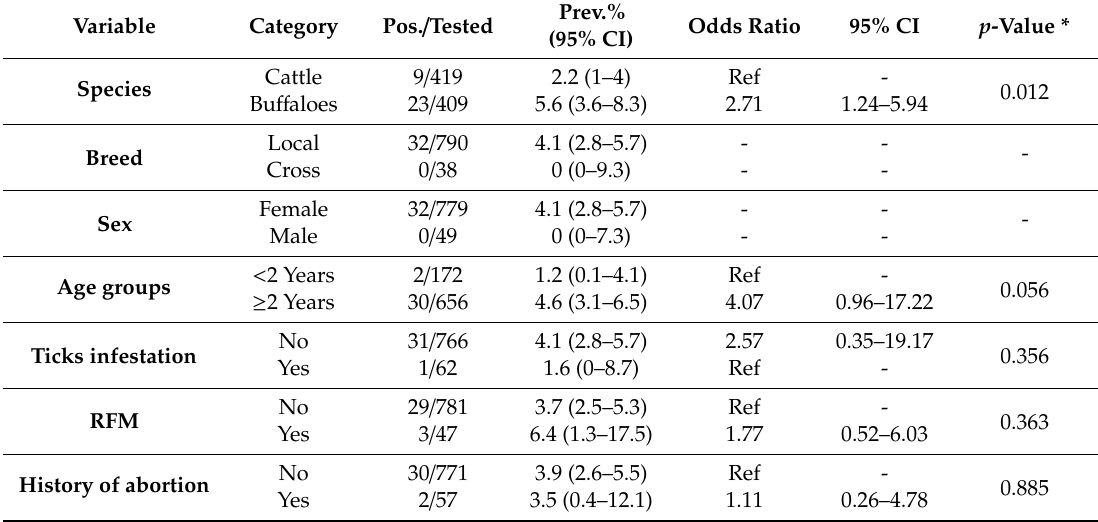
Table 3. Univariable in cattle and bu ff aloes at animal level.